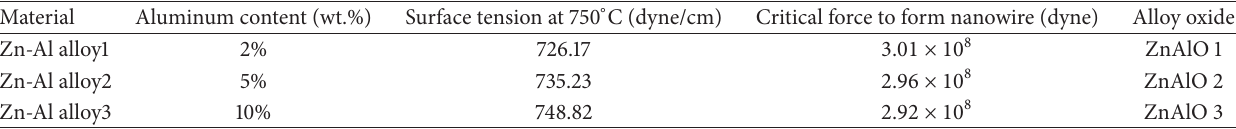
Figure 3: The effect of aluminum content on the resistance of zinc aluminum oxide gas sensor upon exposure to the various concentrations of oxygen at an operating temperature of 100 ∘ C. Table 1: Al content, surface tension, and critical force to form nanowire of zinc-aluminum alloys prepared in this study. Material Aluminum content